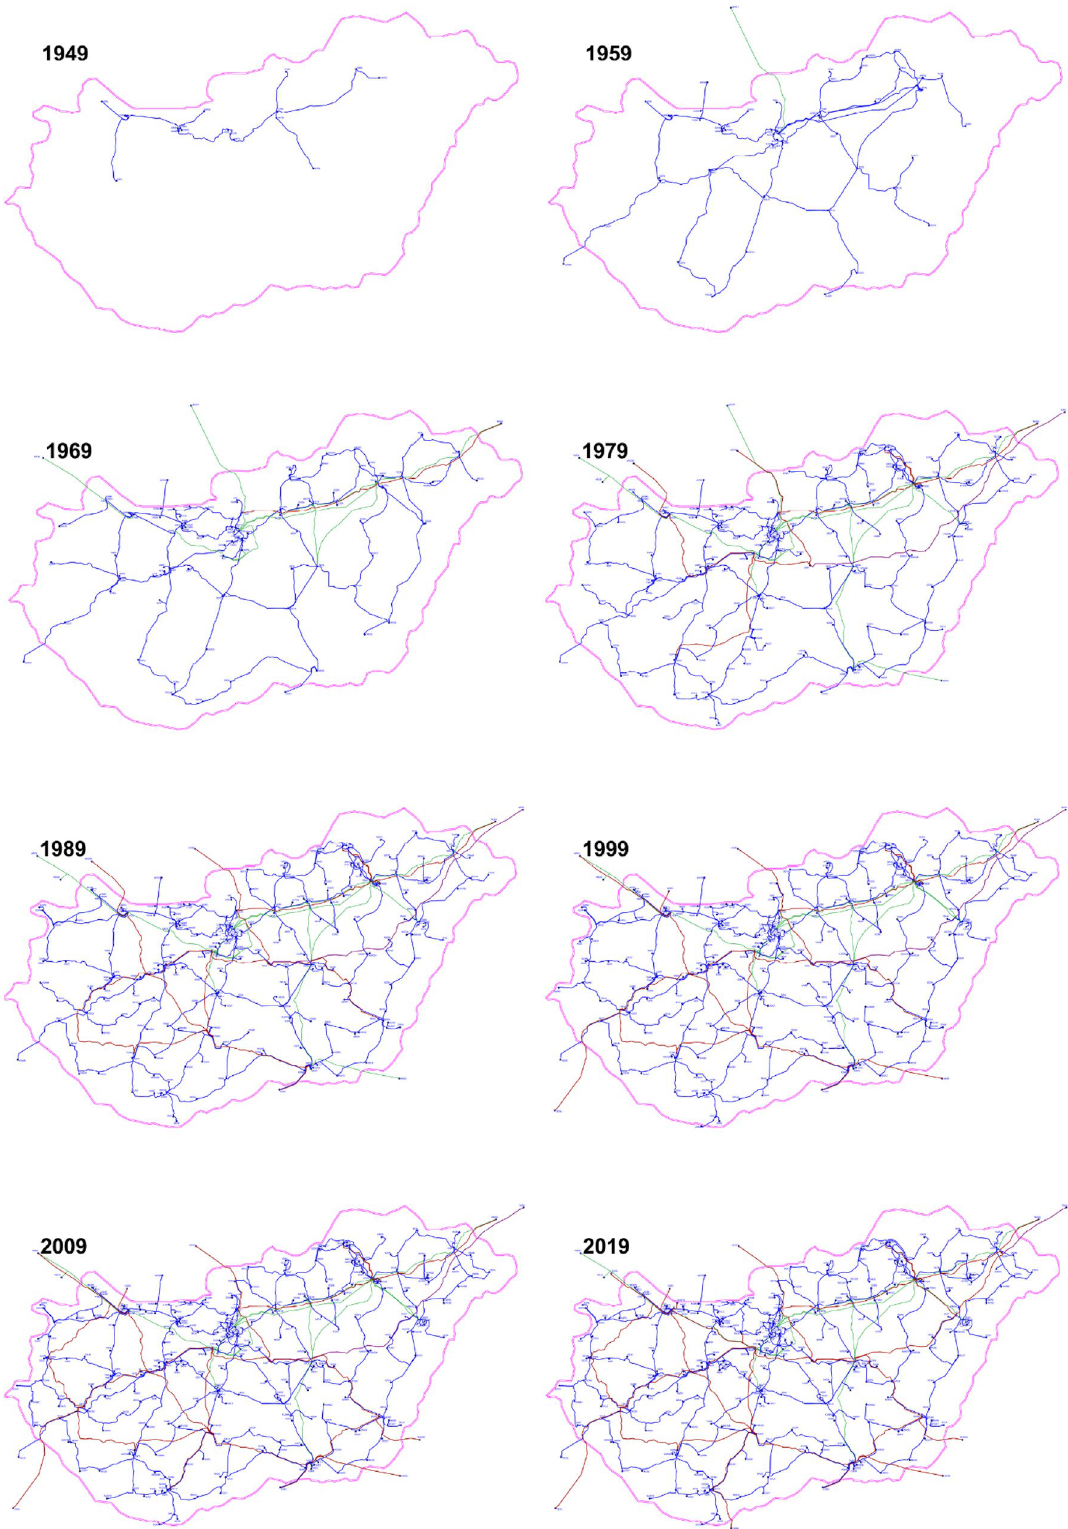
Figure 7. The evolution of the Hungarian power grid, snapshots taken every 10 year. Blue lines represent 120 kV, green lines represent 220 kV, red lines represent 400 kV and the purple lines represent 750 kV power